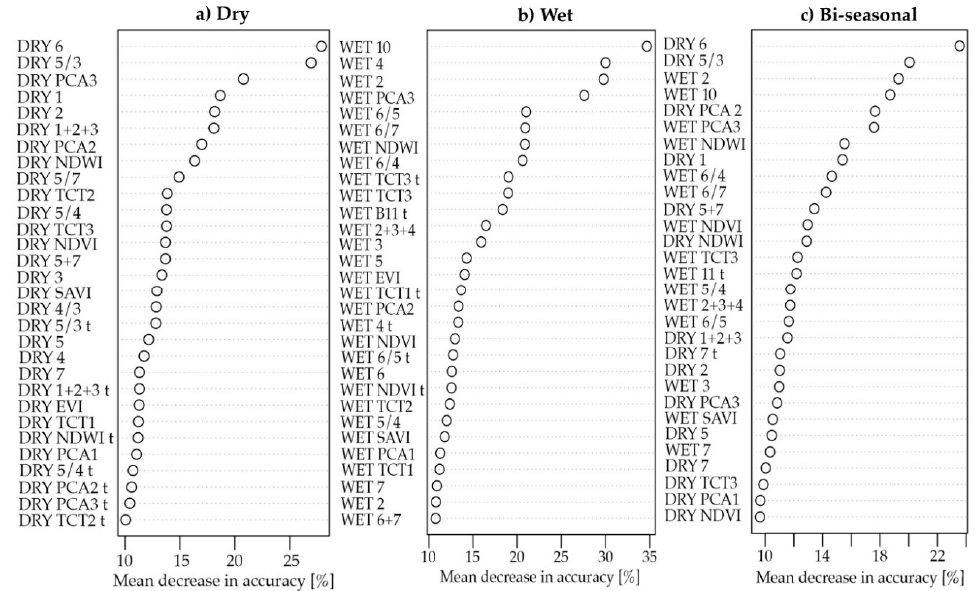
Figure 4. Variable importance measure for the ( a ) dry, ( b ) wet, and ( c ) bi-seasonal RF